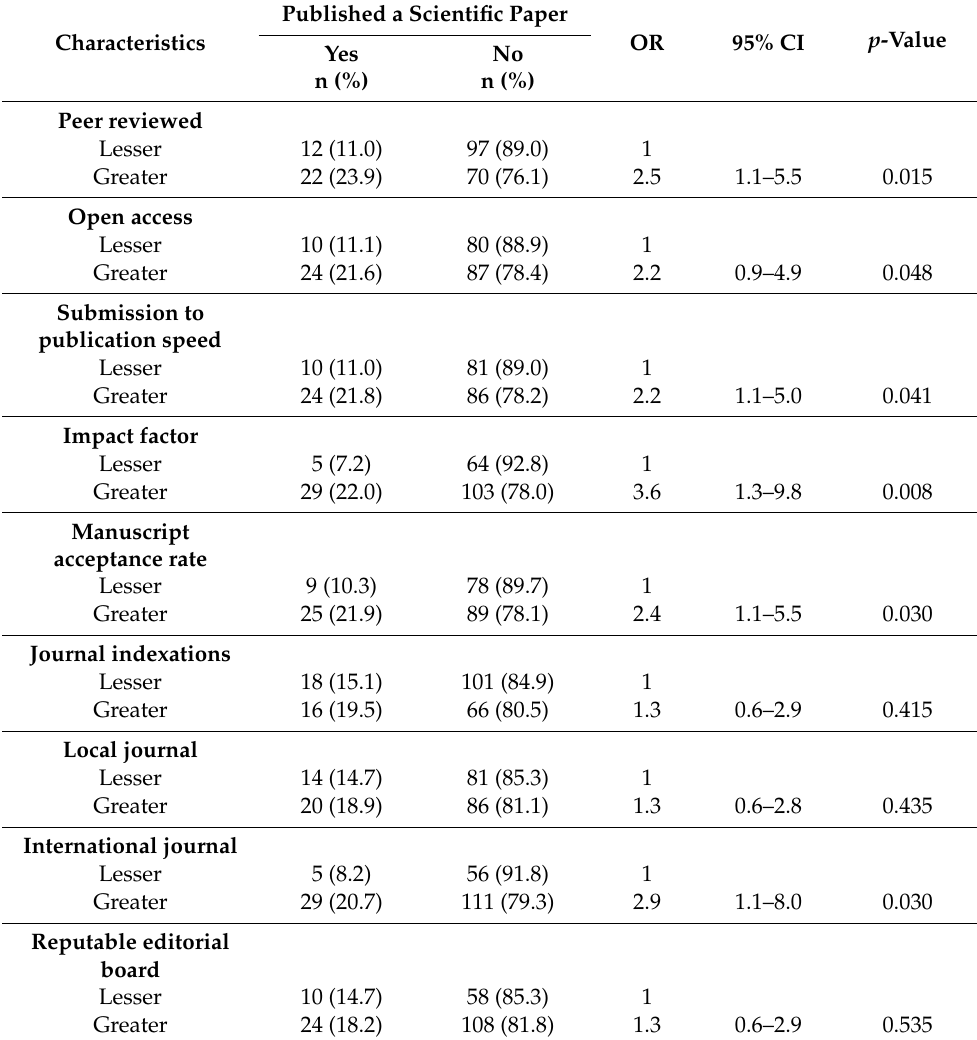
Table 5. Association between Journal Selection Attributes and Publication Output ( n =